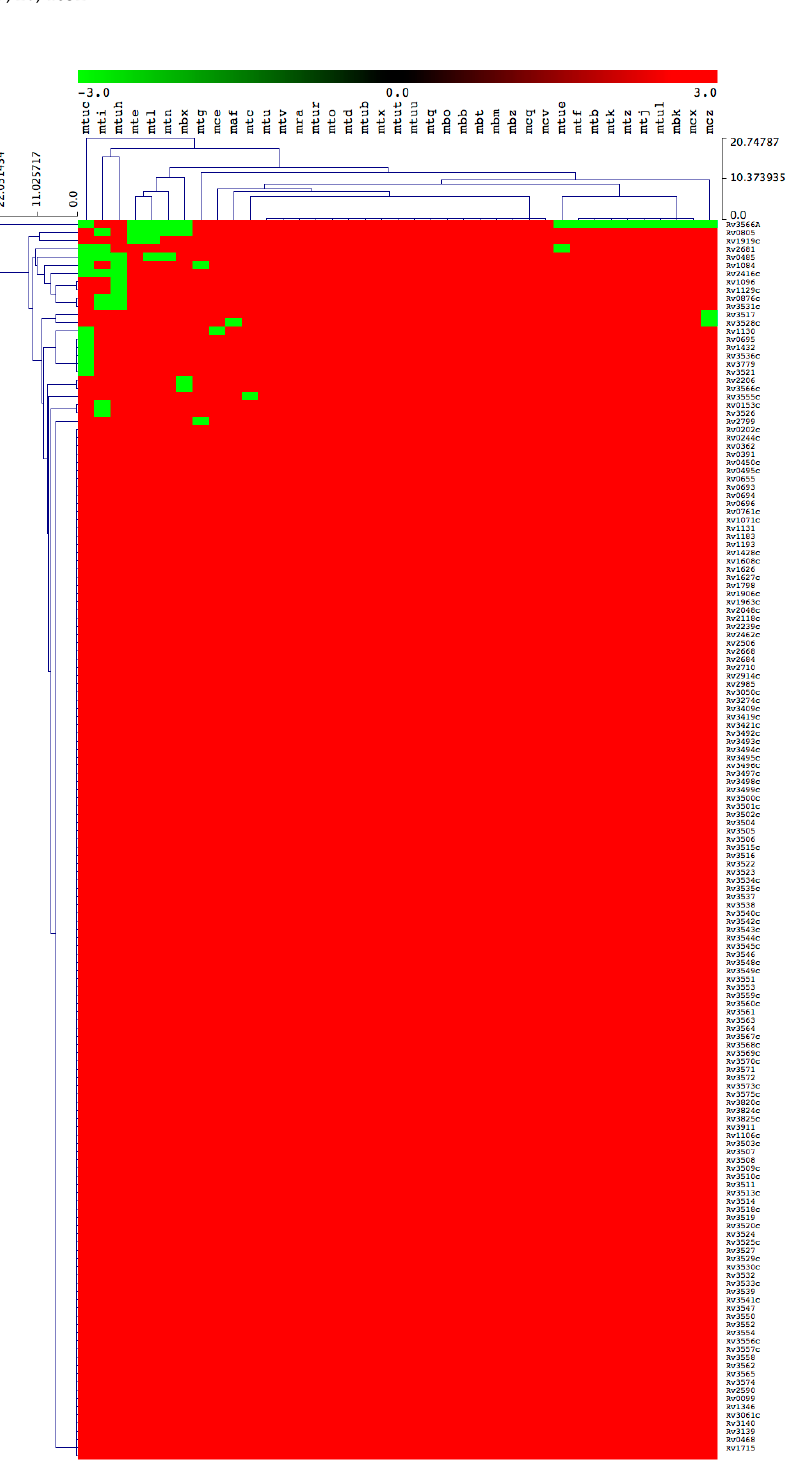
Figure 4. Heatmap of presence or absence of 151 cholesterol catabolic genes/proteins in 39 M. tuberculosis complex species. The data have been represented as –3 for gene absence (green) and 3 for gene presence (red). There are 39 mycobacterial species represented on the horizontal axis (see Table 3 for species codes) and 151 genes/proteins on the vertical axis.